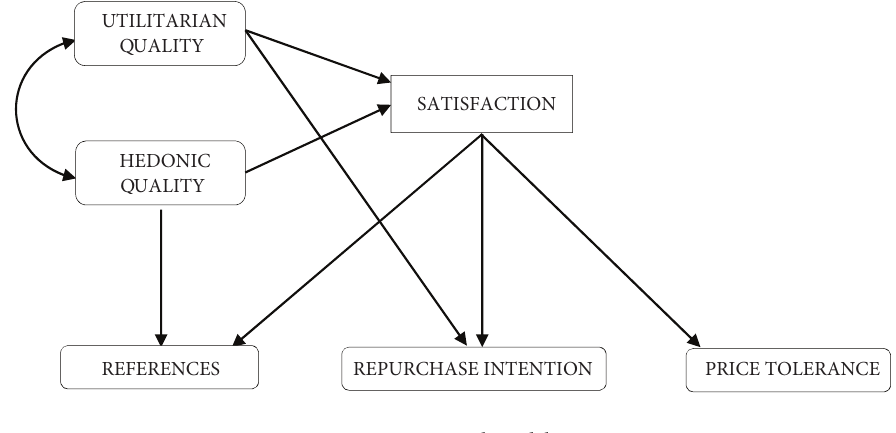
Figure 3. Structural